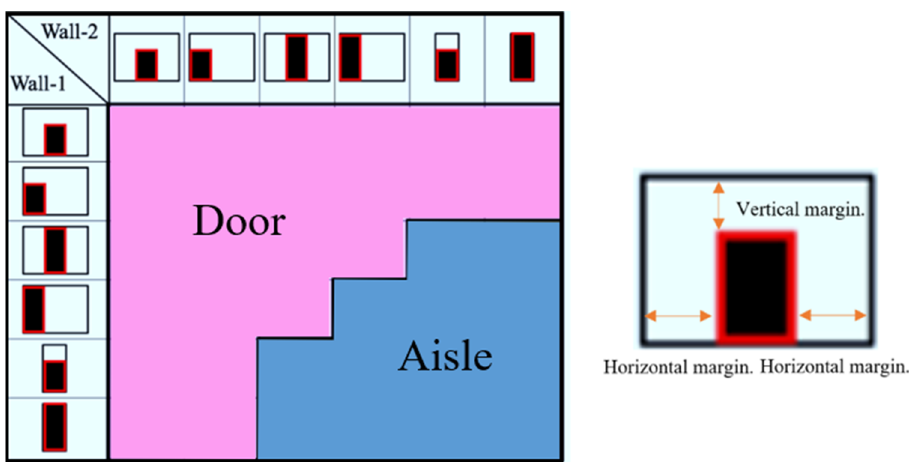
Figure 7. Initial and additional boundaries of the 2D room candidates.